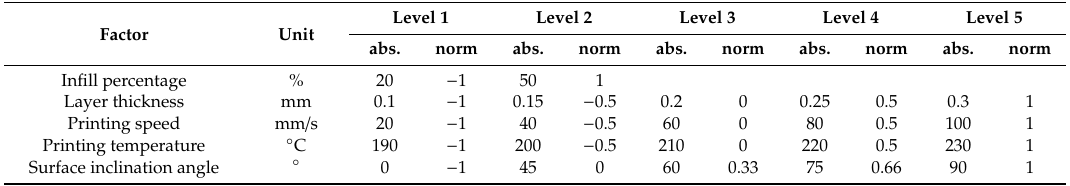
Table 2. The controllable factors and their absolute and normalized level values.